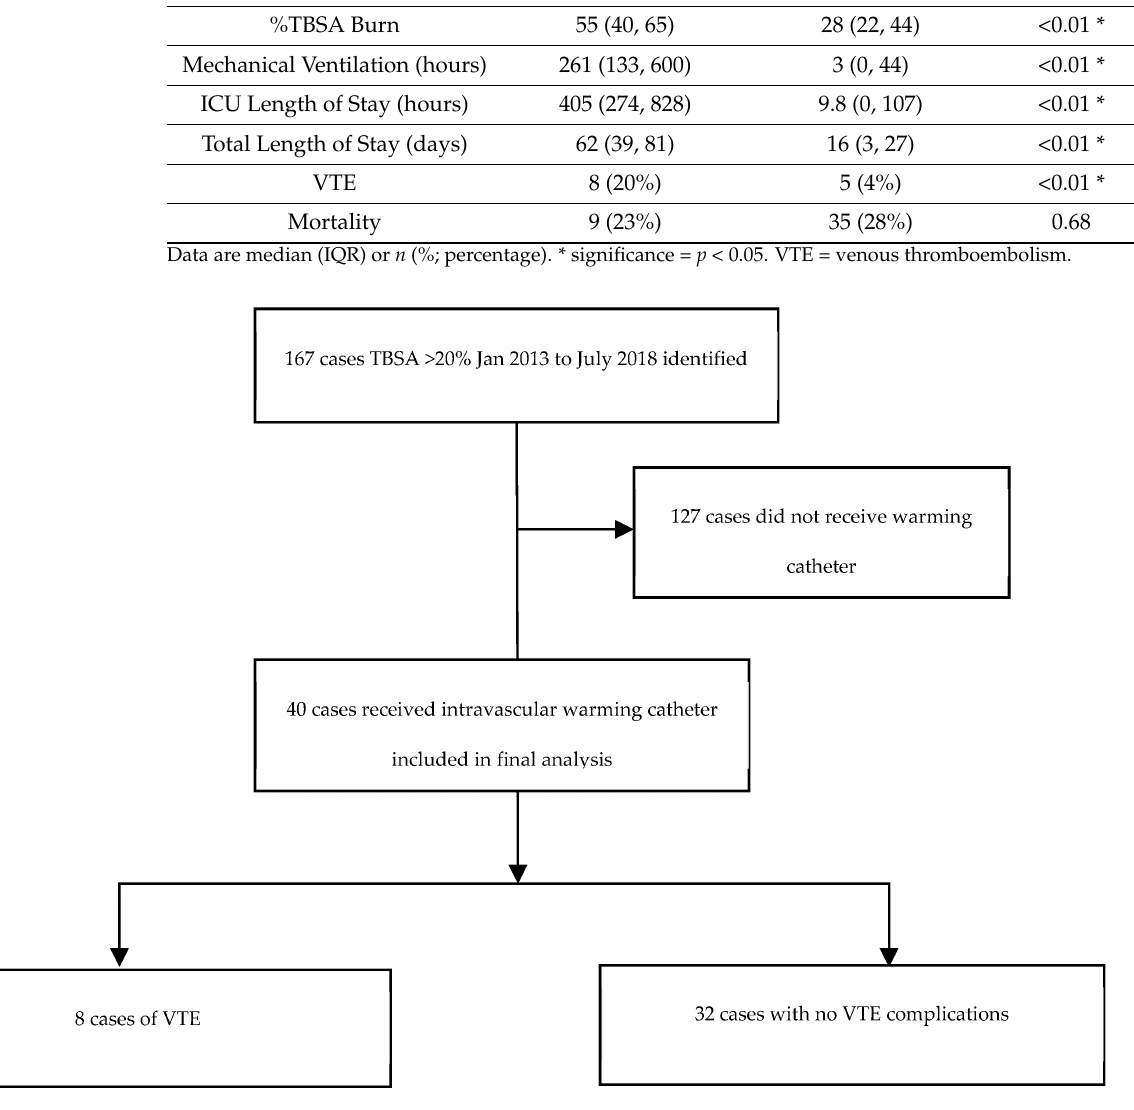
Figure 1. Cohort for analysis. Table 1. Characteristics of patients with total body surface area affected (TBSA) >20% according to insertion of intravascular warming